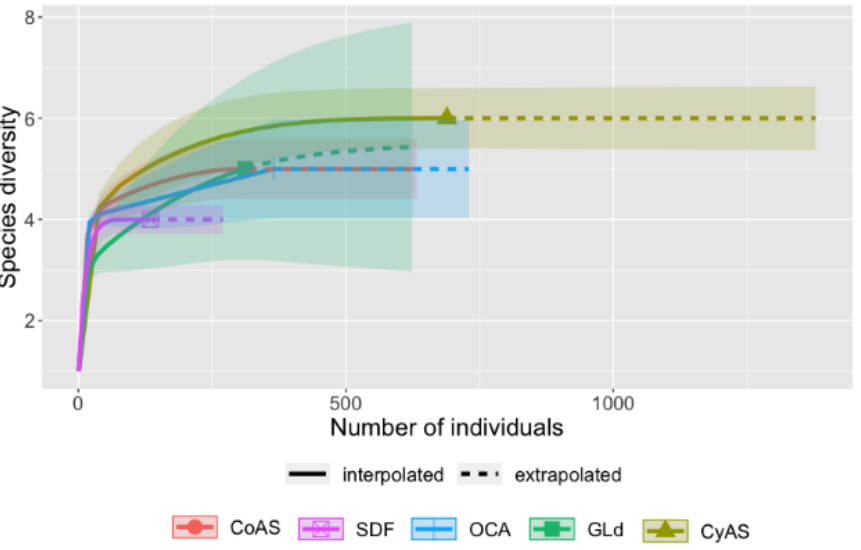
Figure 2. Extrapolation curves of the assemblages of Scarabaeinae sampled for five land uses, Ecua- dor.